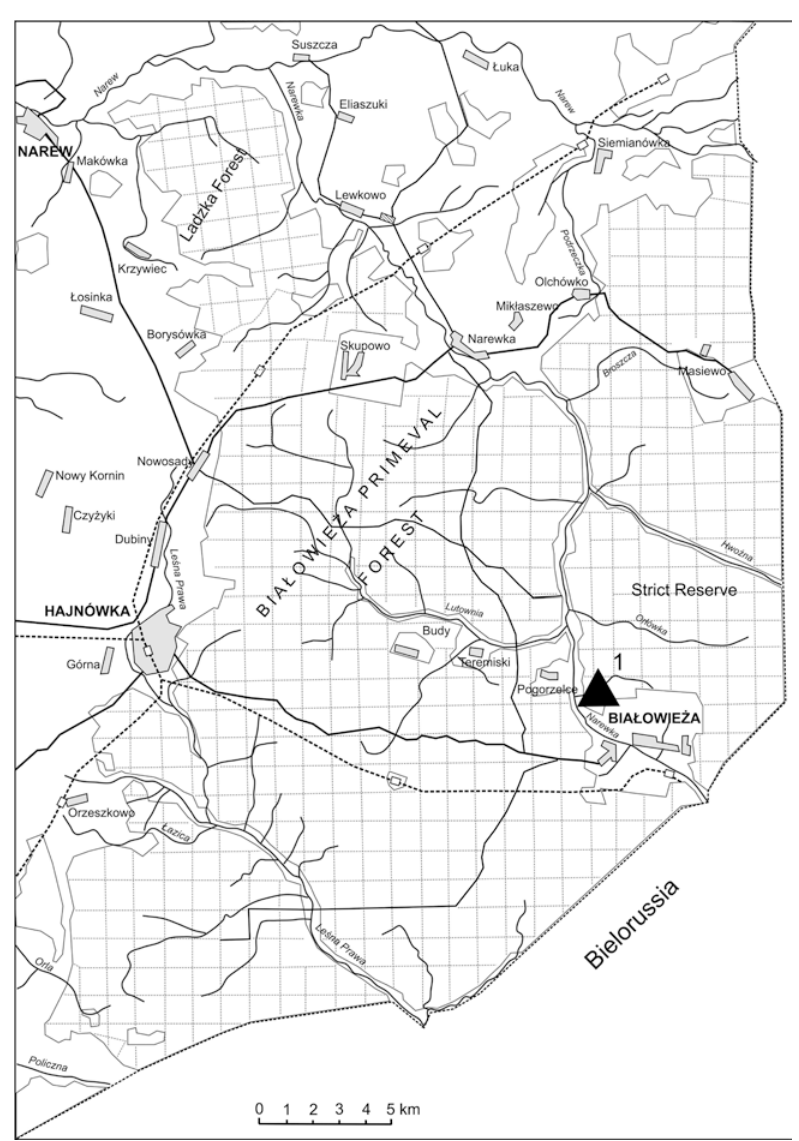
Fig. 1. The Białowieża Forest �acc. to Faliński 1986, modified� – distribution of Gloiodon strigosus in the Białowieża Forest. 1-locality in the Area of Strict Protection of the Białowieża National Park